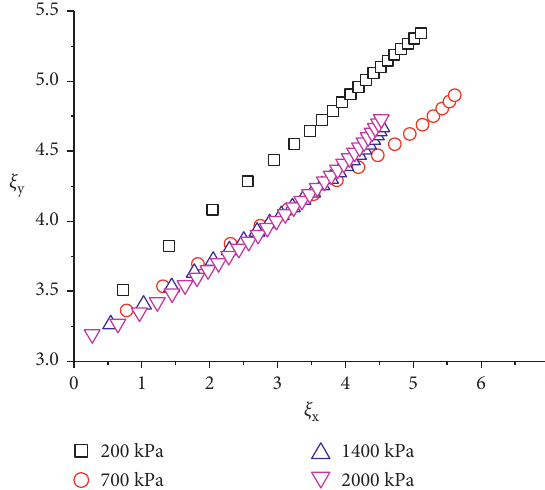
Figure 9: CT tests of limestone rockfill materials